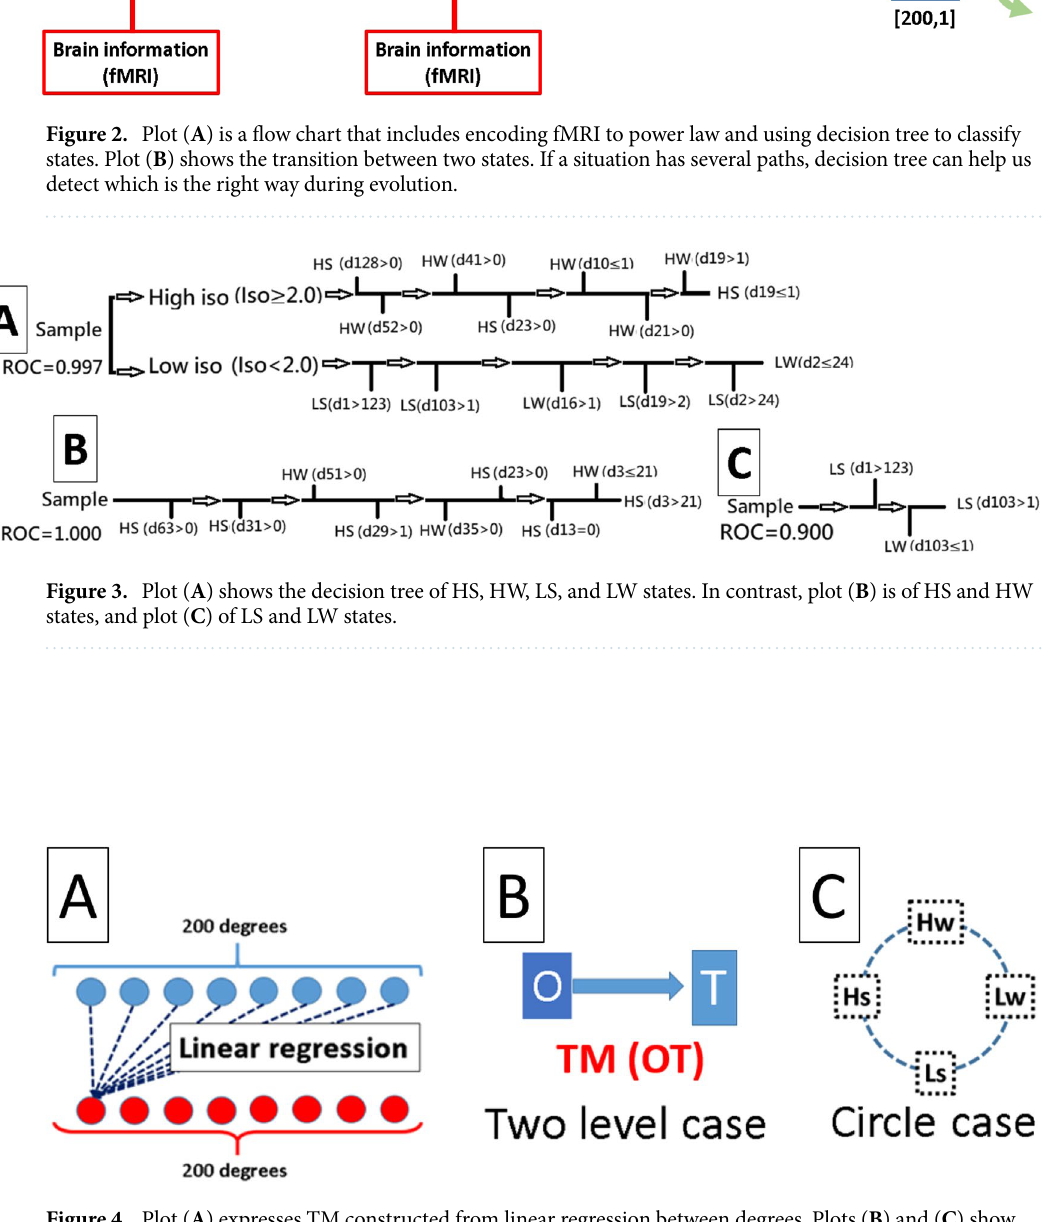
Figure 4. Plot ( A ) expresses TM constructed from linear regression between degrees. Plots ( B ) and ( C ) show the simulation about two level transition and four level